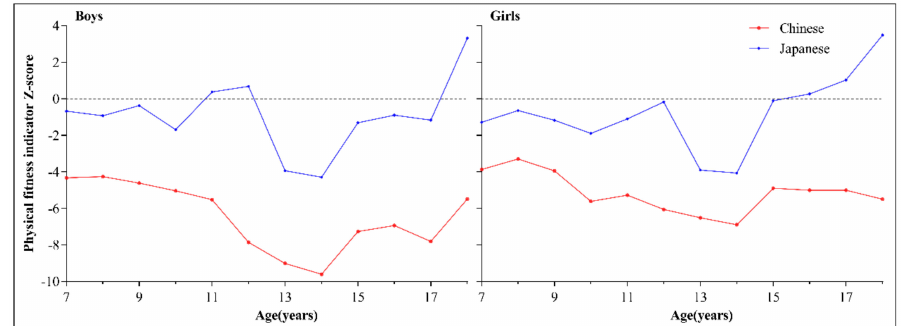
Figure 2. Age trends by gender of the physical fitness index for children and adolescents aged 7–18 years in China and Japan.